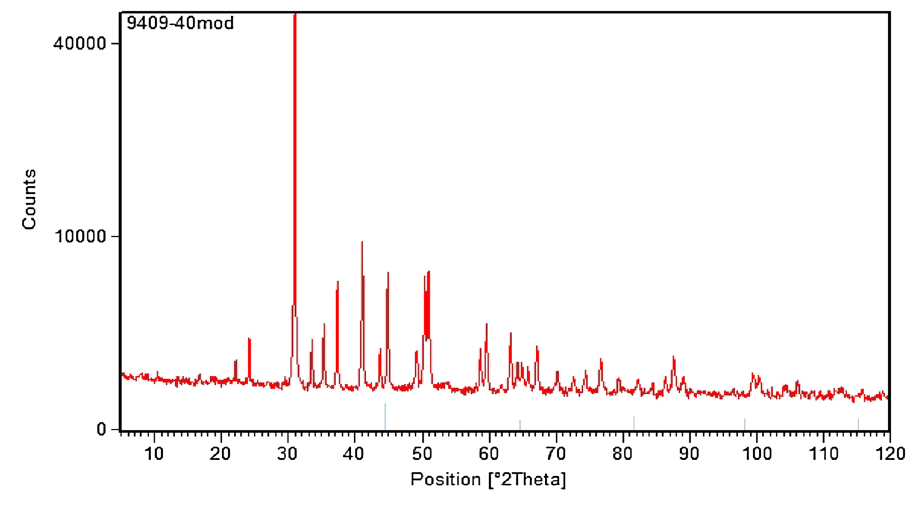
Fig. 1 Result of performed XRD test